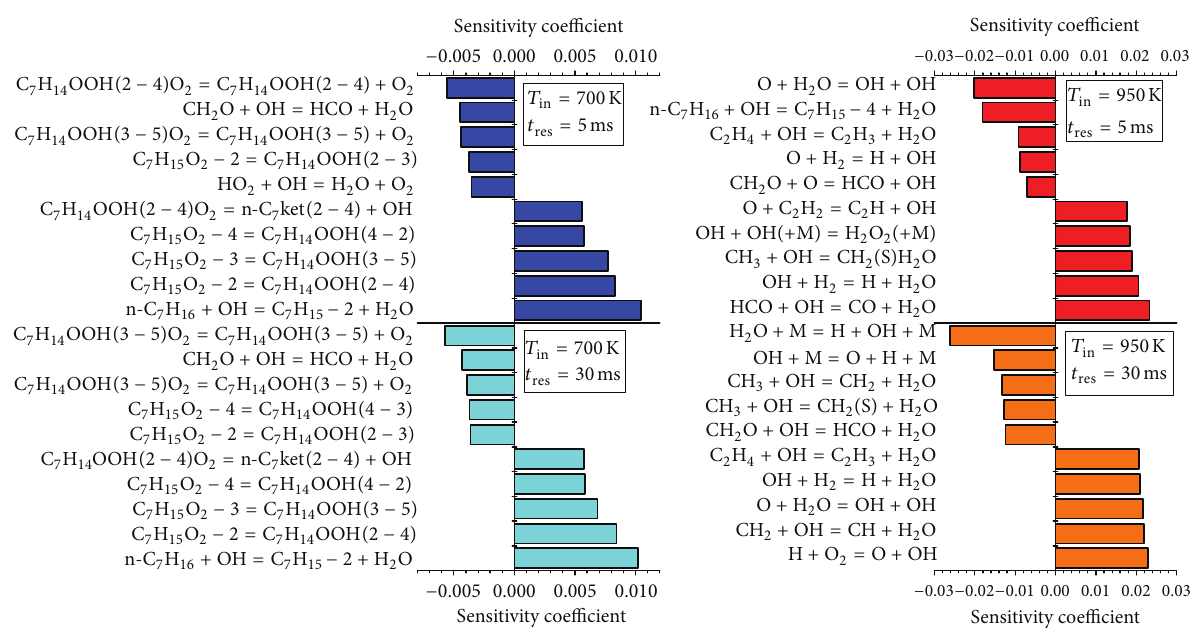
= 700 K (cool flame regime) and 𝑇 = in in = 0.06 ). fuel